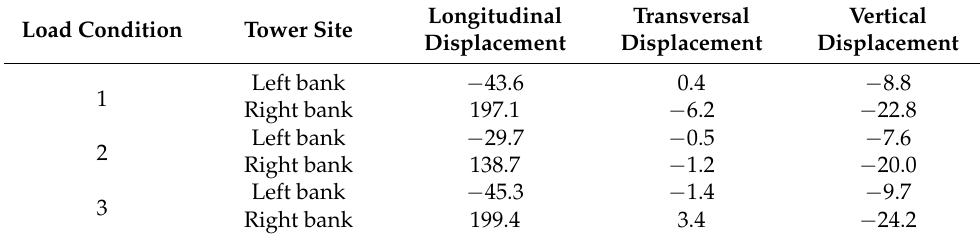
Table 6. Maximum numerical displacements at tower top (unit: mm). Load Condition